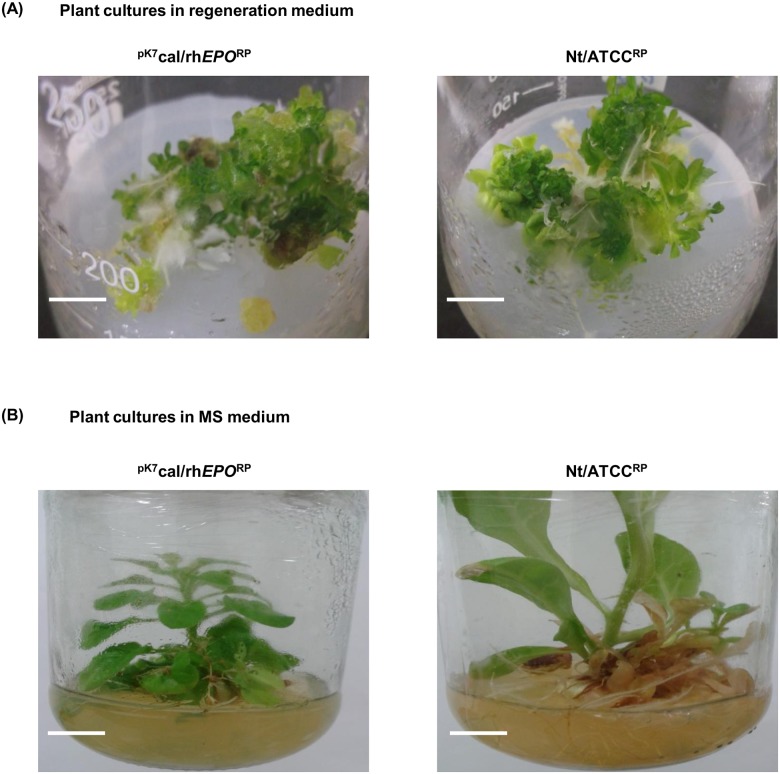
Regeneration of T0 tobacco plantlets.(A) The 2 week old transgenic or control calli were cultured in regeneration medium. Scale bars are 5.8 cm. (B) The 4 week old transgenic or control regenerated T0 plantlets (pK7cal/rhEPORP or Nt/ATCCRP respectively) were grown in MS medium. Scale bars are 5.9 cm.